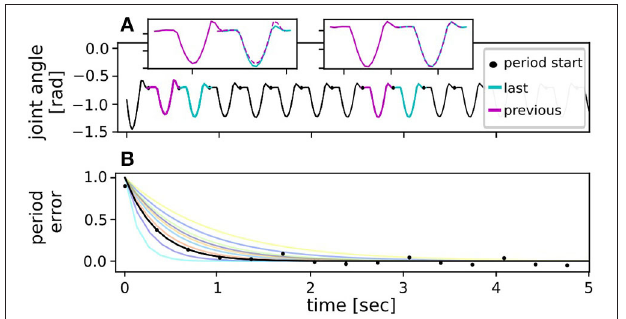
FIGURE 3 | Data analysis to derive stability metric. (A) To find the convergence errors for the stability metric, the joint trajectory in each (last) period was compared to the previous one by autocorrelation, where a period was defined to start at the maximum body height in flight phase. The overlayed trajectories of the two periods were subtracted resulting in a cumulative error value per period. (B) The cumulative error value determined for every period was expected to decrease with time after a disturbance and reach zero once the hopping leg returned to a limit cycle motion. To better compare the convergence properties of the different fall heights, the error curves were normalized for the different test conditions and then fitted with an exponential curve over all repetitions. Exemplary data (black) are shown for a simulated fall from 12 cm while being controlled by the reflex. Curve fits for all other fall heights are shown in other